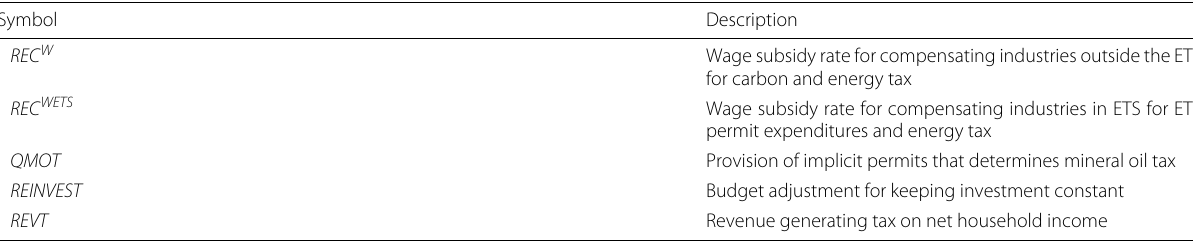
Table 14 Variables in the CEPE model ( Continued )